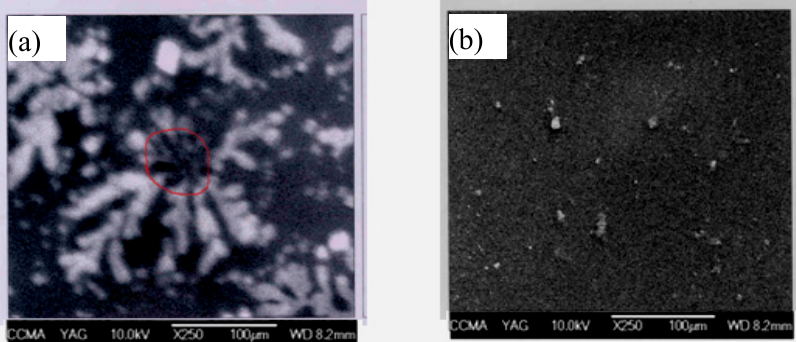
Figure 11. ( a ) The FEGSEM pictures of alumina–silica glass-based phase-separated and ( b ) non-phase-separated Er-doped fiber preforms obtained on heating of the same preform around 1900 °C and above 2100 °C, respectively.